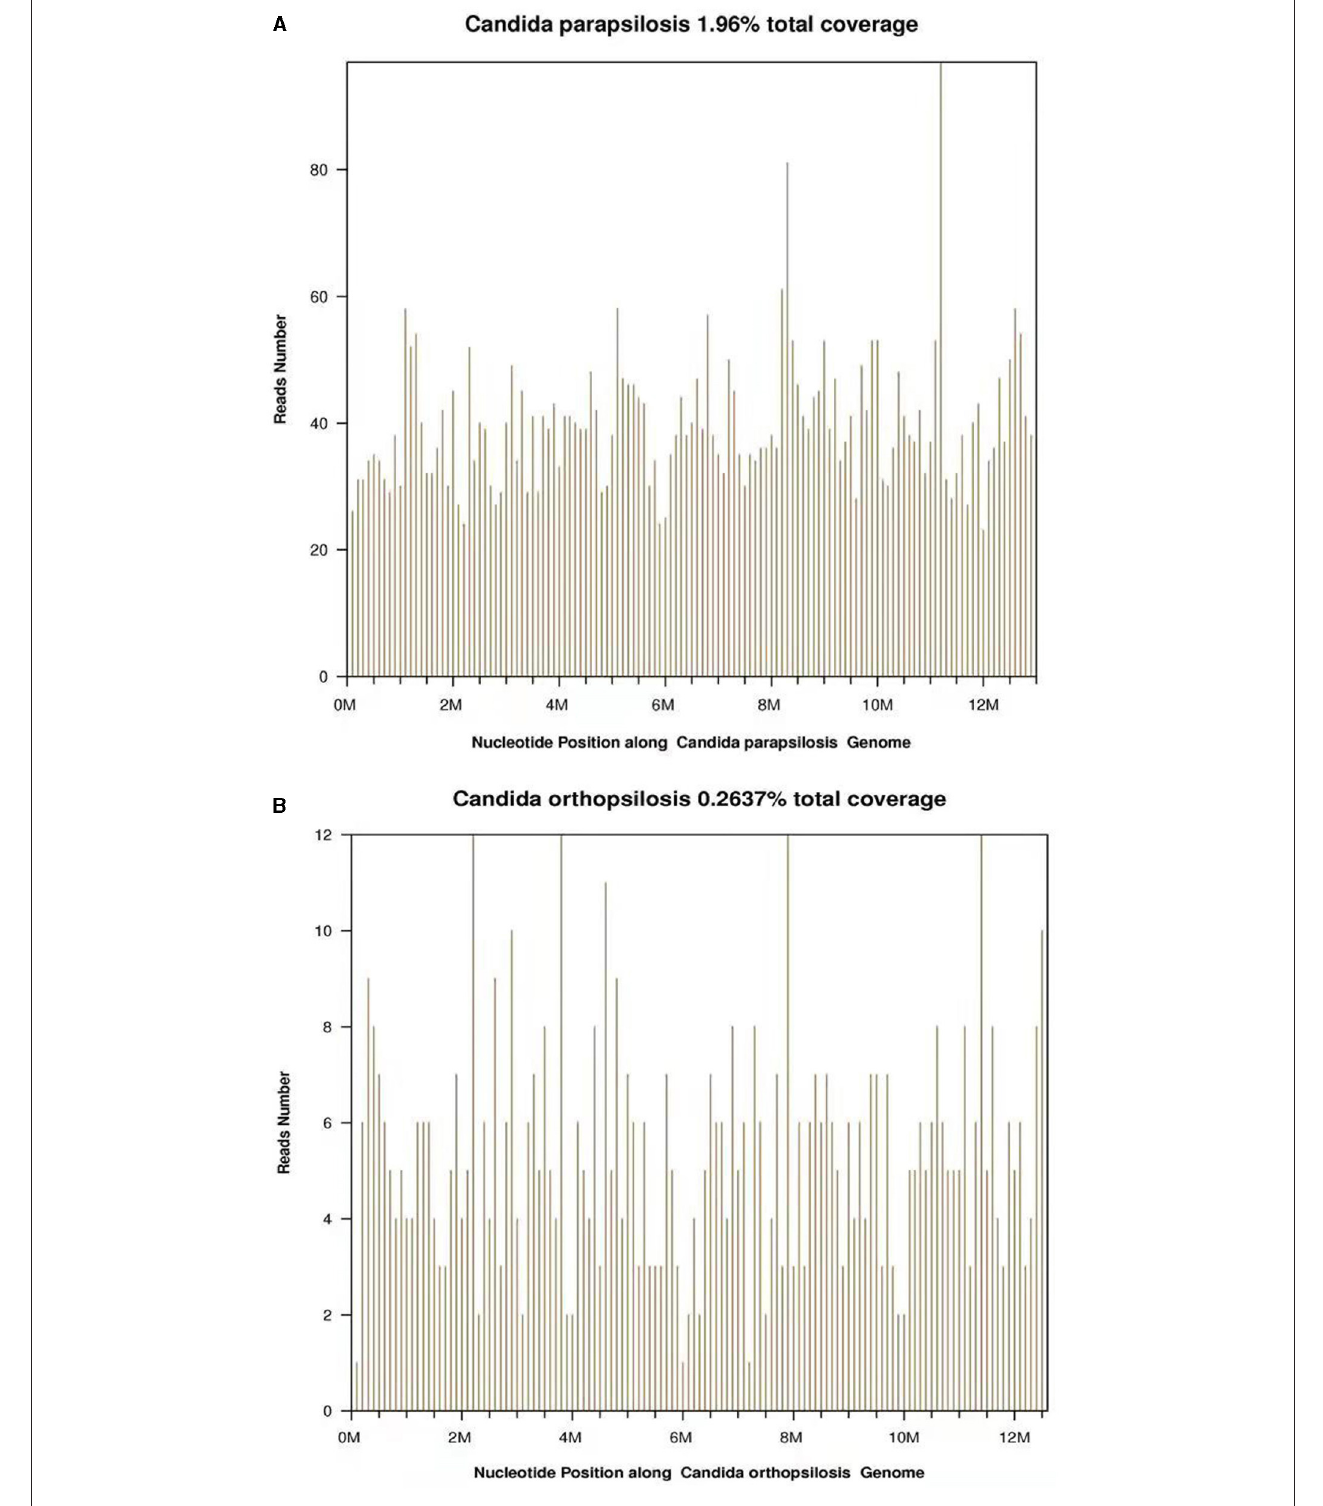
FIGURE 1 | (A) A total of 5,212 reads were mapped to the Candida parapsilosis in the reference database. The coverage of the referenced Candida parapsilosis genome was 1.96%. (B) A total of 675 reads were mapped to the Candida orthopsilosis in the reference database. The coverage of the referenced Candida orthopsilosis genome was